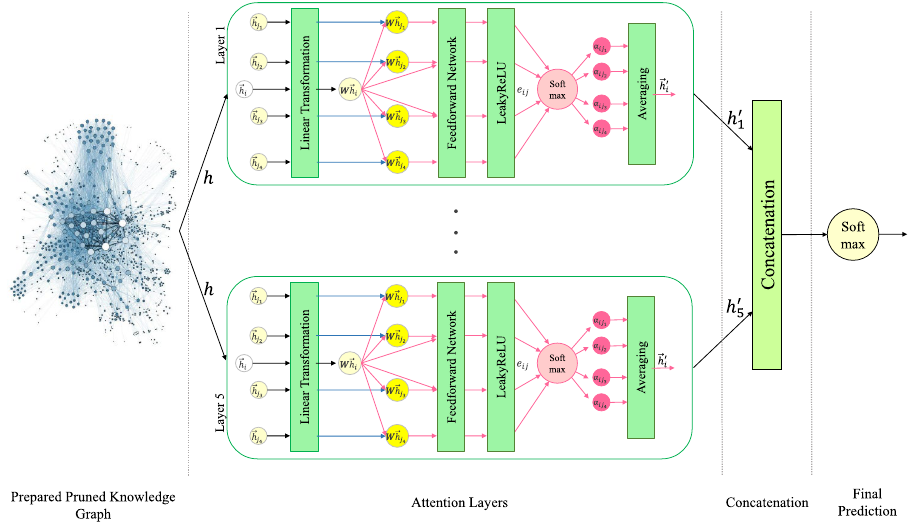
Figure 3. The architecture of knowledge graph attention network classifier. The pruned knowledge graph is fed into the attention layers as a set of node features h = corresponding set of features after applying attention mechanism, namely h ′ = outputted set of node features from each layer (namely h ′ l , l ∈ { 1, 2, .., 5 } ), are concatenated to produce the final